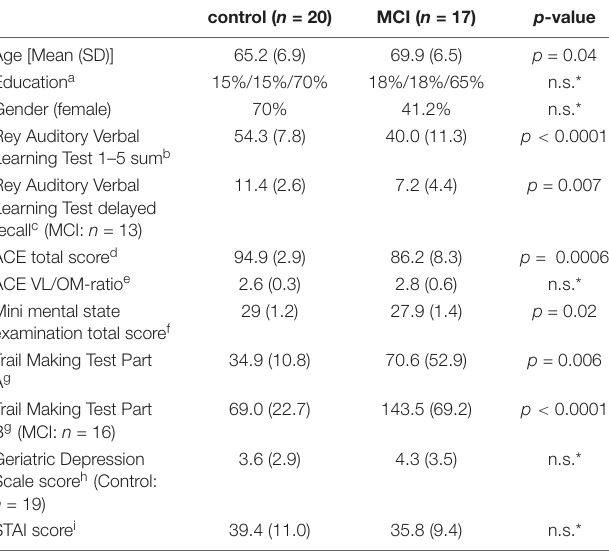
TABLE 1 | Demographic data and results of basic neuropsychological tests.